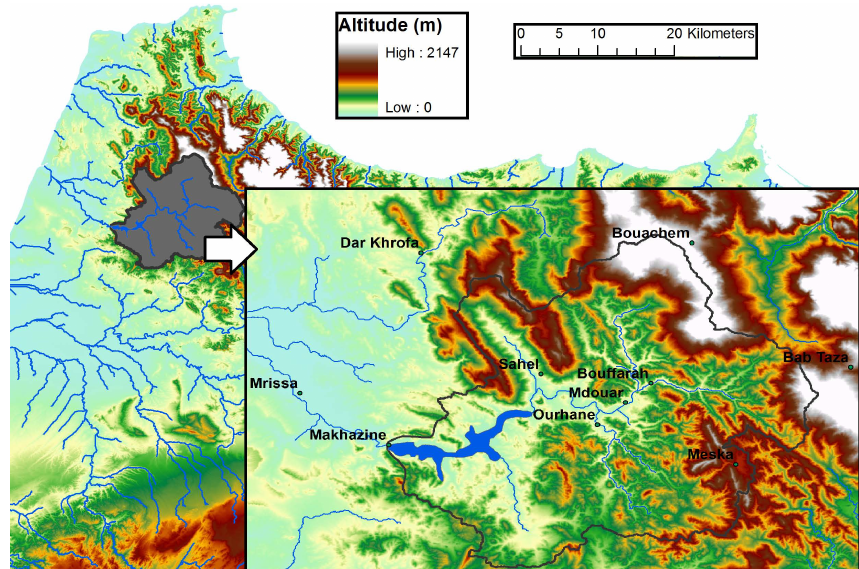
Fig. 1. The Makhazine catchment and location of the rain gauge stations.